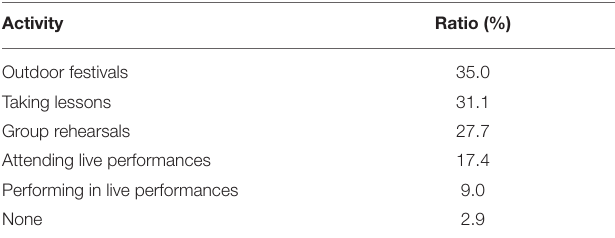
the observed variables obtained in the factor analysis. All relationships between variables were statistically tested, and the SEM algorithm found the best-fit structure. Before conducting the SEM path analysis, all the data were normalized. The